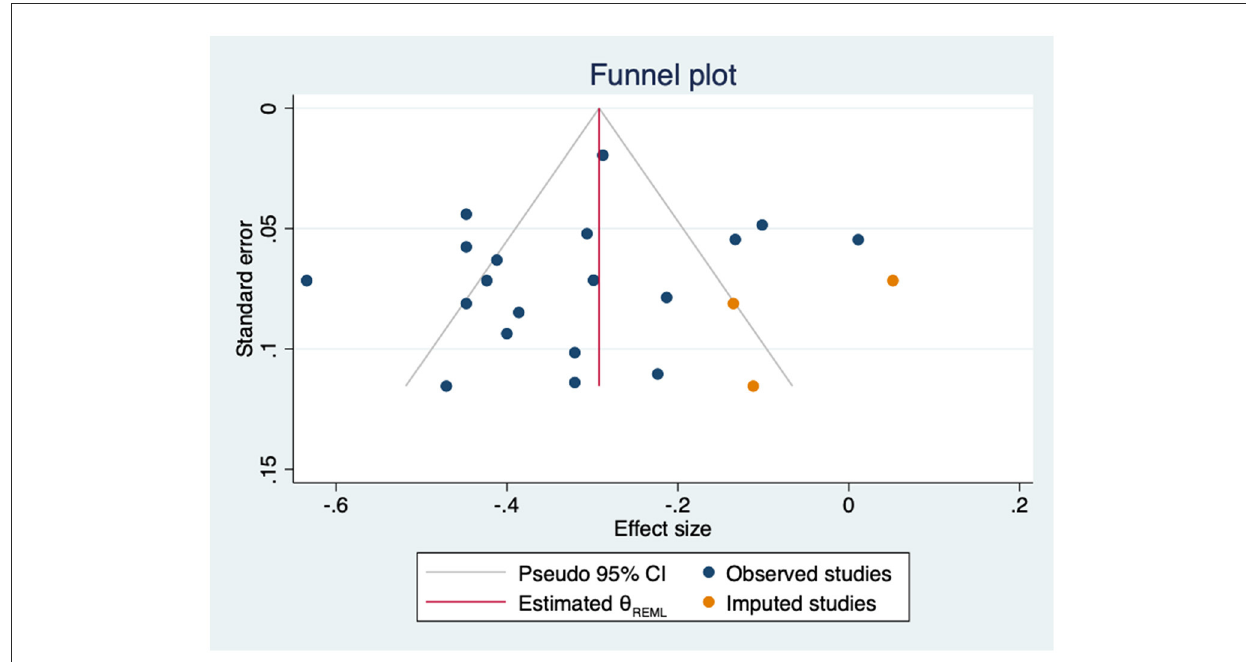
FIGURE8 Funnel plot with trim-and-fill imputations for the association between empowerment and